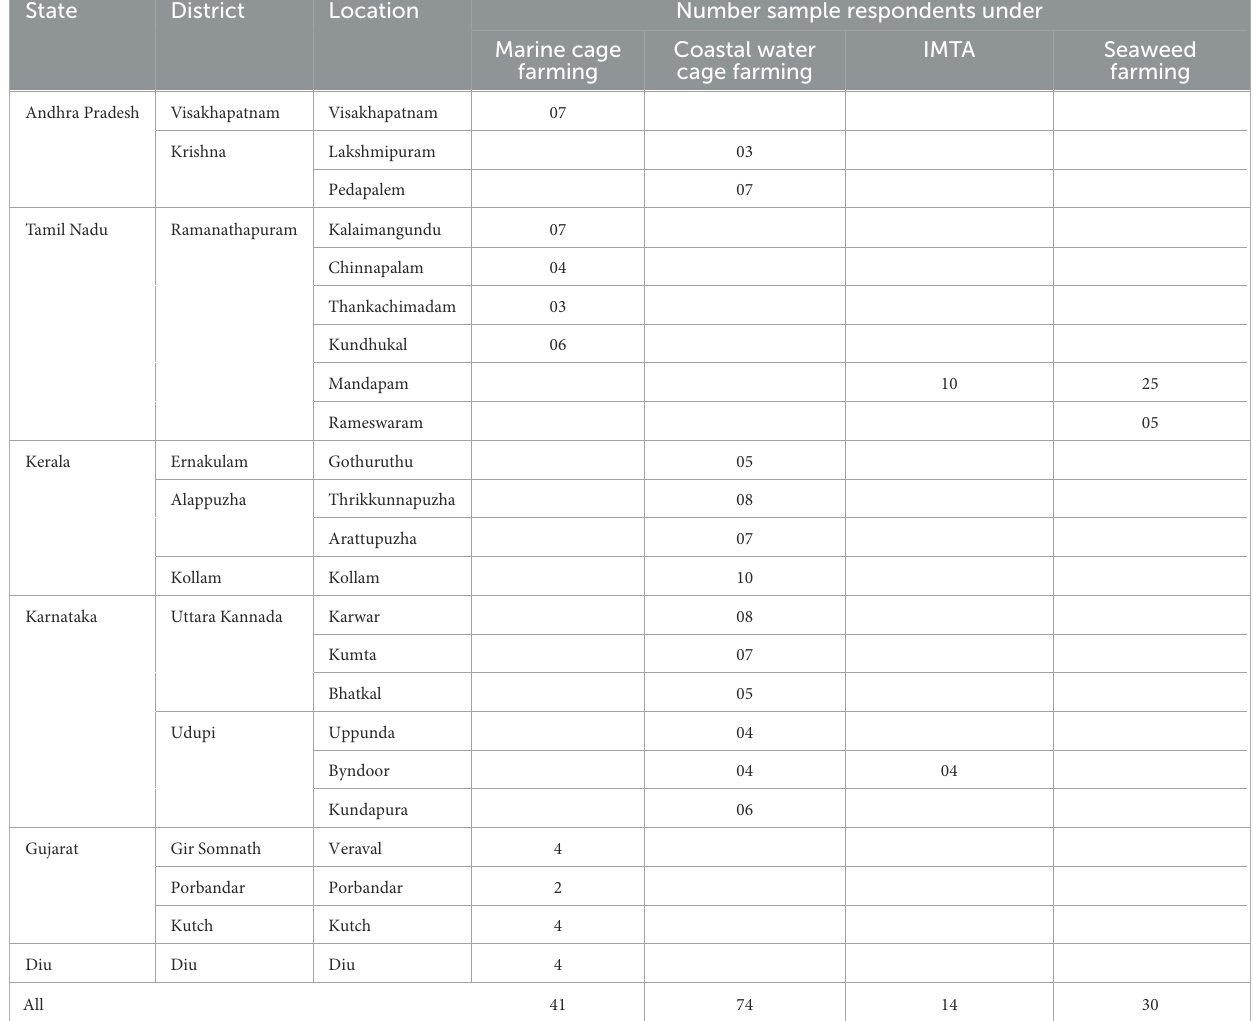
TABLE A1 Sampling framework for primary data collection in selected coastal states of India,